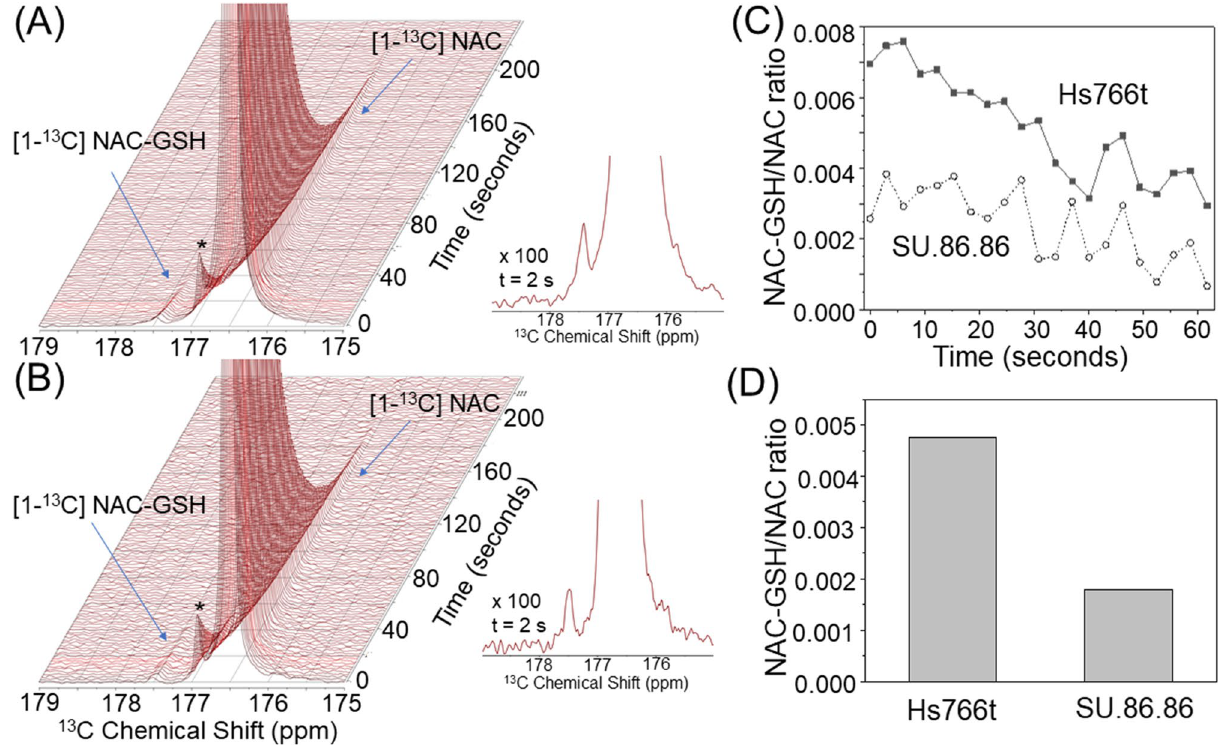
Figure 2. Real-time monitoring NAC metabolism in in cell NMR spectroscopy of tumor cell lines. In cell dynamic 13 C NMR spectra of hyperpolarized [1- 13 C] NAC at 1 T NMR on 20 × 10 6 cells of human pancreatic tumor cell lines of Hs766t (A, left) and SU.86.86 (B, left). Expanded spectra with 100 times magnifications at 2 s after the hyperpolarized [1- 13 C] NAC injections in Hs766t ( A , right) and SU.86.86 ( B , right) cells. ( C ) Time dependence of NAC-GSH/NAC peak intensity ratio after mixing HP-NAC with PDAC cells. ( D ) Comparison of the ratios of NAC-GSH to NAC between Hs766t and SU.86.86 cell lines. A chemical shift peak around 177 ppm indicated with asterisk (*) is assigned as the dimeric form of